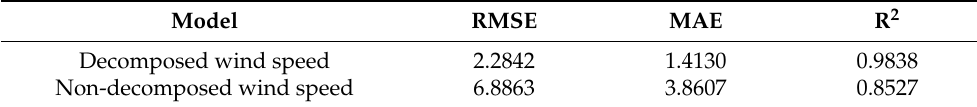
Table 2. Evaluation indexes with and without decomposing wind